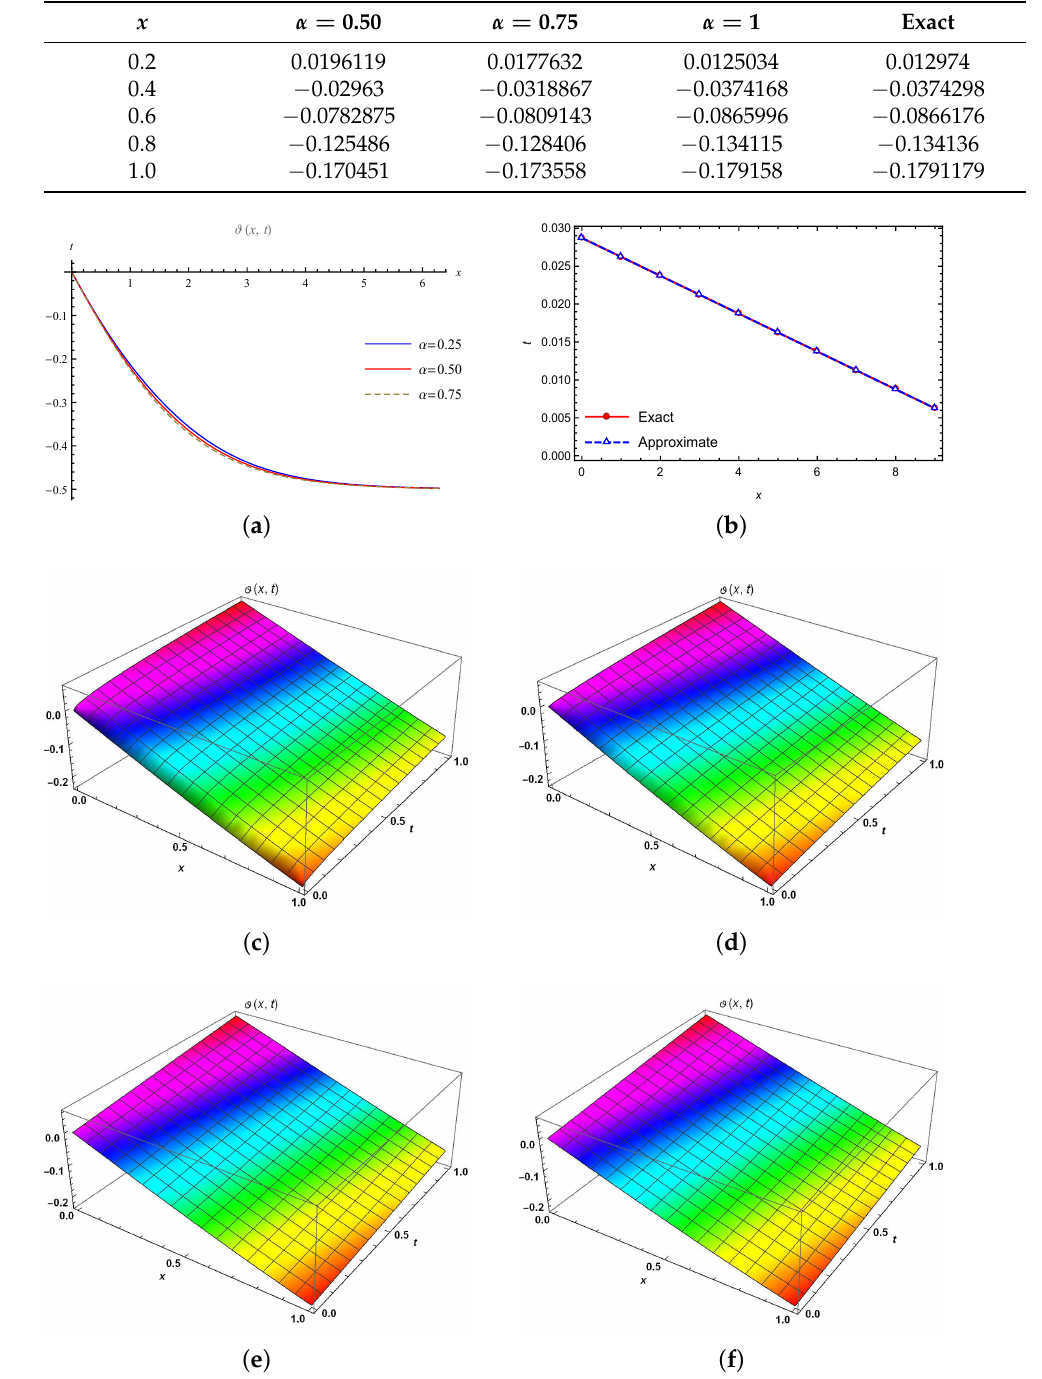
Figure 3. The surface solutions with different fractional orders. ( a ) Approximate solution plot of Equation (17) for different values of α . ( b ) Approximate solution of Equation (17) and exact solution of Equation (18) at α = 1. ( c ) The surface solution of Equation (17) at α = 0.50. ( d ) The surface solution of Equation (17) at α = 0.75. ( e ) The surface solution of Equation (17) at α = 1. ( f ) The surface solution of Equation (18) at α =